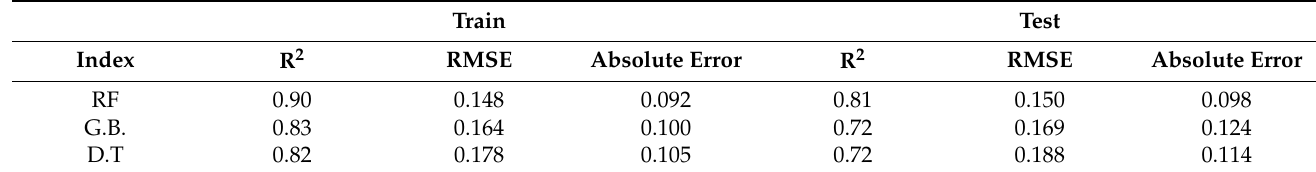
Table 4. Modeling performance with five